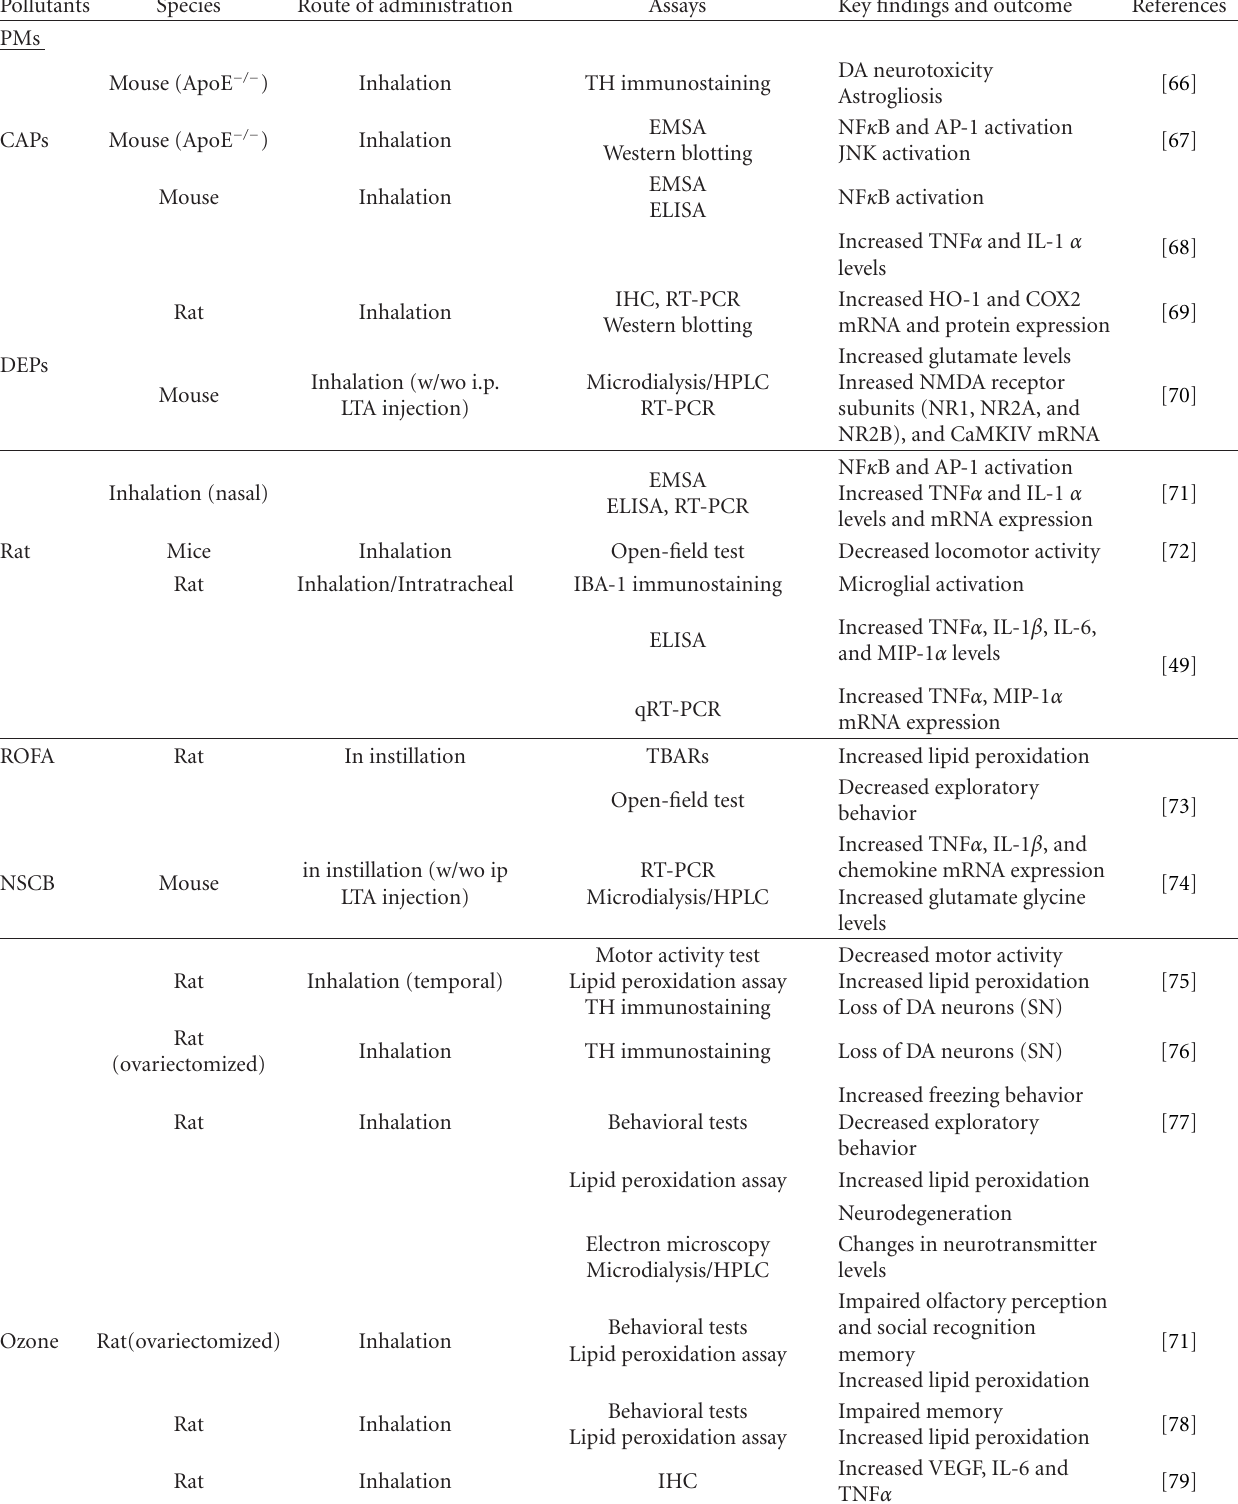
Table 2: The e ff ects of air pollutants on the central nervous system in